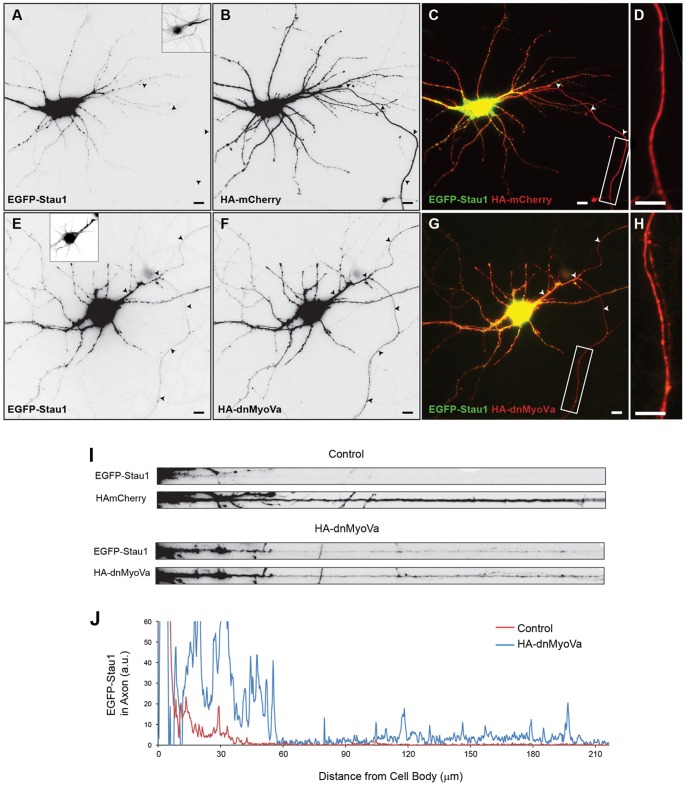
Myosin Va is necessary for somatodentritic targeting of EGFP-Stau1.
A. Following expression in a cortical neuron in dissociated culture EGFP-Stau1 is present in the soma and dendrites, but not in the axon. B. Co-expressed HA-mCherry localizes to the axon as well as to the soma and dendrites in the same cell as in (A). C. Merge of HA-mCherry (red) and EGFP-Stau1 (green). D. High power image of boxed region from (C). E. EGFP-Stau1 is present in the axon as well as in the soma and dendrites when co-expressed with HA-dnMyoVa (F), a dominant-negative variant of Myosin Va. Arrowheads point to the axon. Scale bars represent 10 μm. G. Merge of HA-dnMyoVa (red) and EGFP-Stau1 (green). H. High power image of boxed region from (G). I. A straightened axon from the neuron in (A-D) co-expressing HA-mCherry (upper panel) shows a relative absence of EGFP-Stau1 staining. In contrast, a straightened axon from the neuron in (E-H) expressing HA-dnMyoVa (lower panel) shows EGFP-Stau1 staining. J. EGFP-Stau1 staining vs. distance in the distal axon for the neuron in (A-D; red) and the neuron in (E-H; blue).